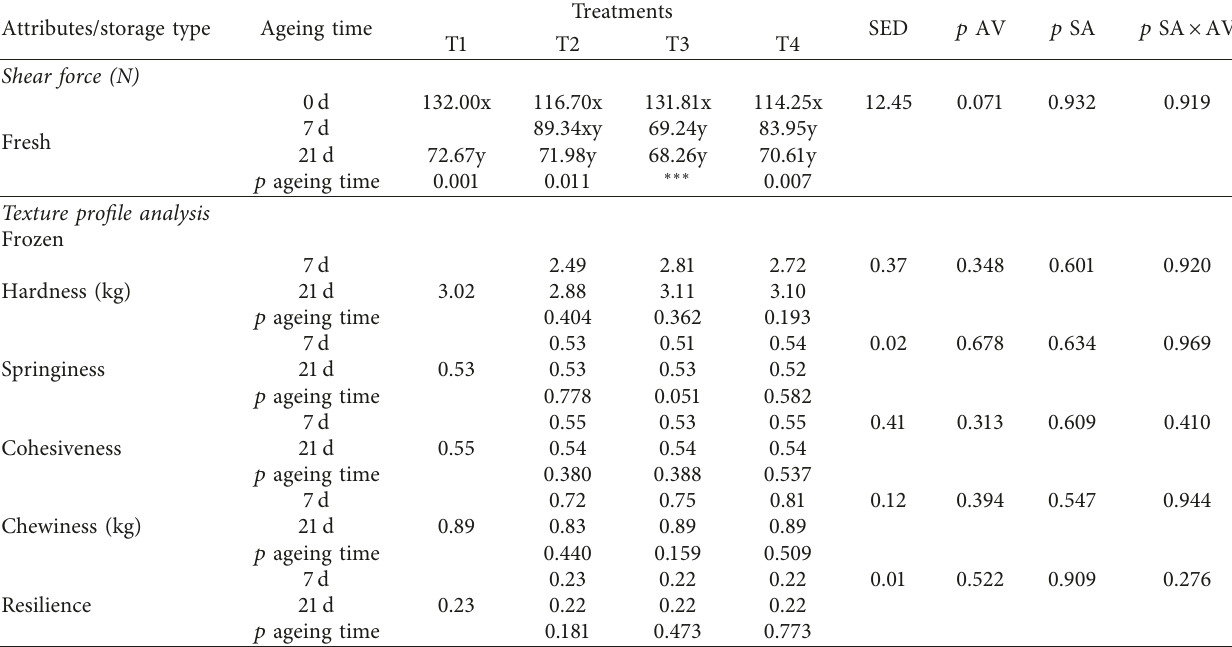
Table 5: Effect of ageing treatments, ageing time, and frozen storage on instrumental texture of in-bag dry-aged lean bull beef. Attributes/storage